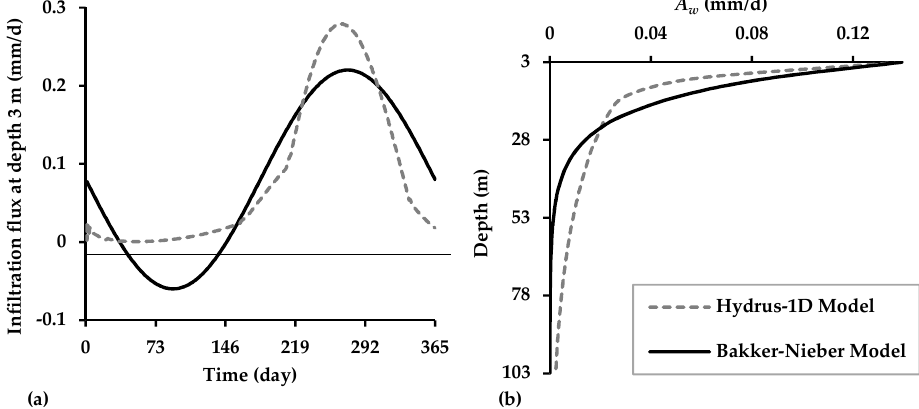
Figure 7. Infiltration flux in the deep zone: ( a ) The periodic variation of the infiltration flux at the depth of 3 m; and ( b ) the change in the fluctuation amplitude of the infiltration flux along depth.